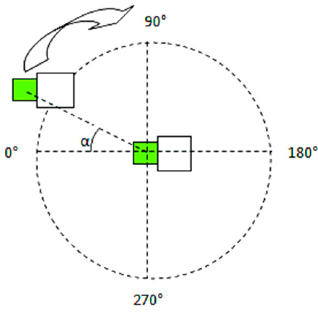
◦ back-to-back measurement setup. Figure 18. A 360° back-to-back measurement setup. Figure 18. A 360 Figure 18. A 360° back-to-back measurement setup.